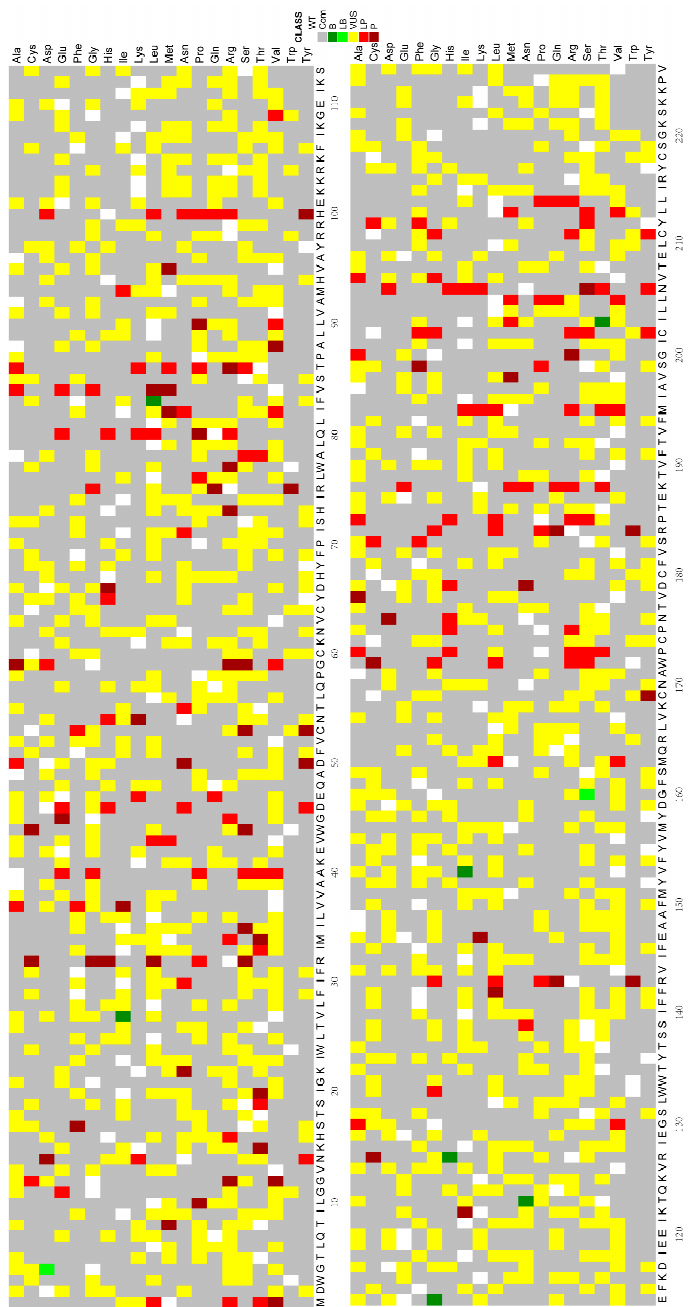
Figure 4. The type (simple and complex) and pathogenicity classification of GJB2 missense variants.